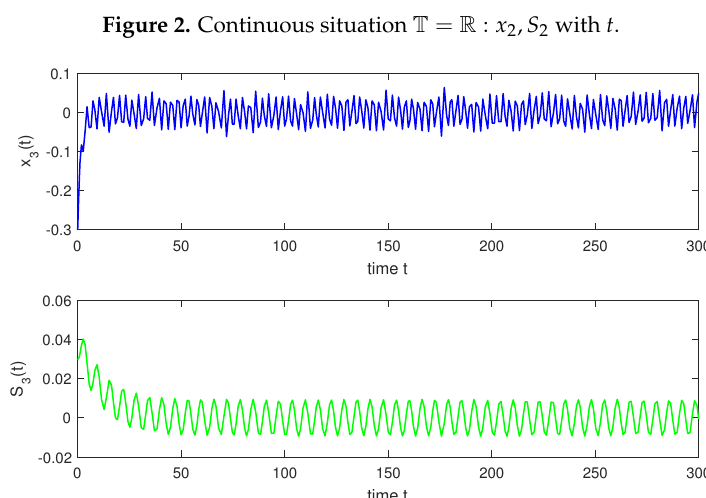
Figure 2. Continuous situation T = R : x 2 , S 2 with t .